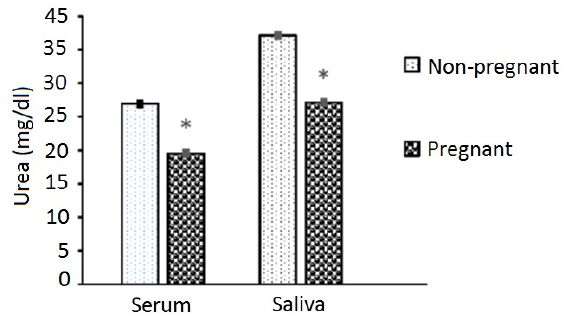
Figure 2. Mean Serum and Salivary Urea Concentrations in Pregnant and Non-pregnant Women. Note . * : A significant difference at P <